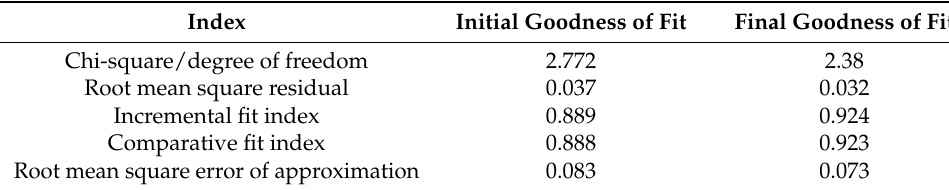
Table 3. Confirmatory factor analysis results for the goodness of